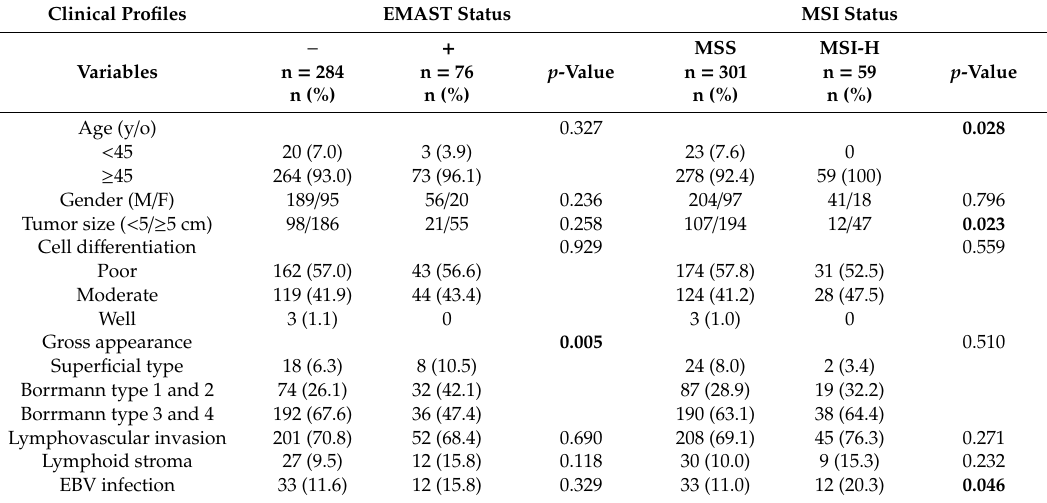
Table 1. Clinical profiles among patients according to the EMAST and MSI